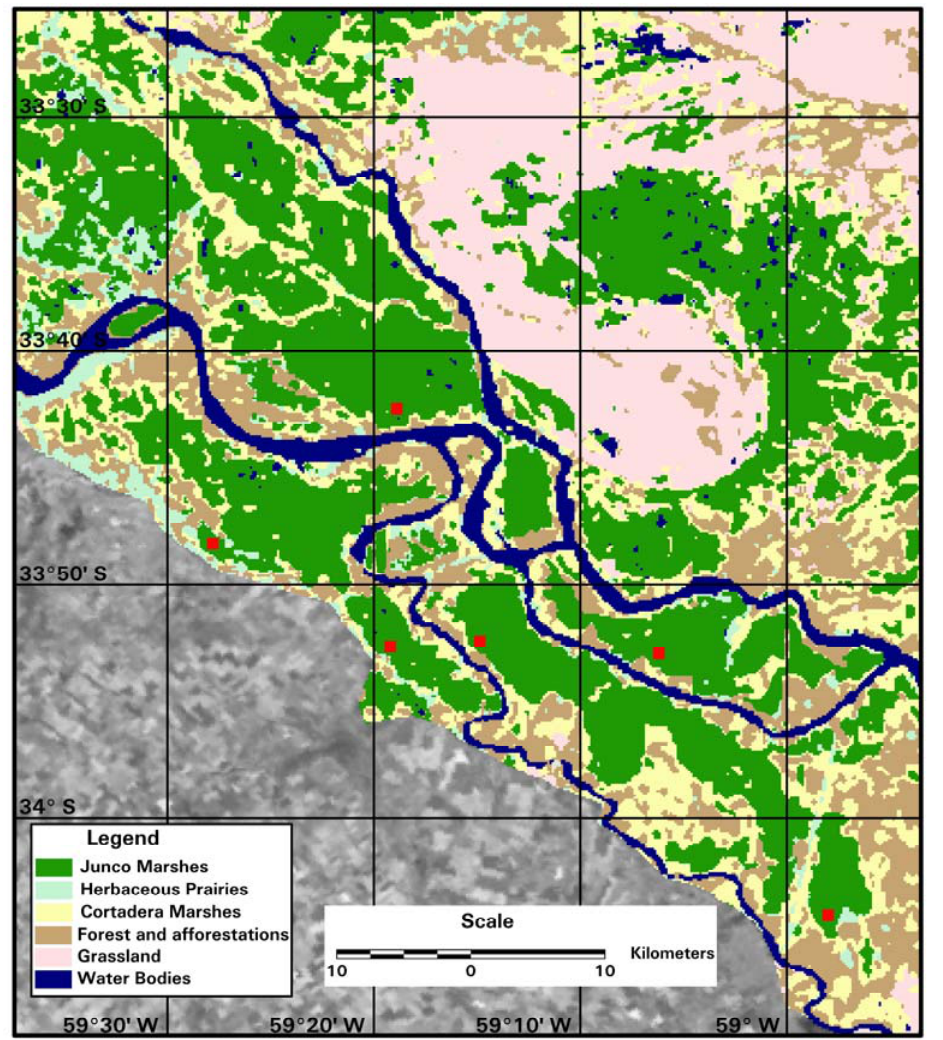
Figure 1. Landcover map of the Paraná River Delta at the beginning of 2008 [9]. Field sites areas are marked in